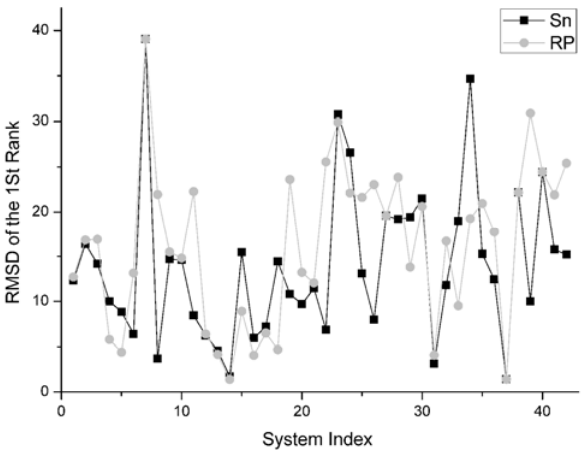
Figure 8. For the unbound dock results, the comparison of the RMSD of the first rank structures obtained from the Sn and the RP score